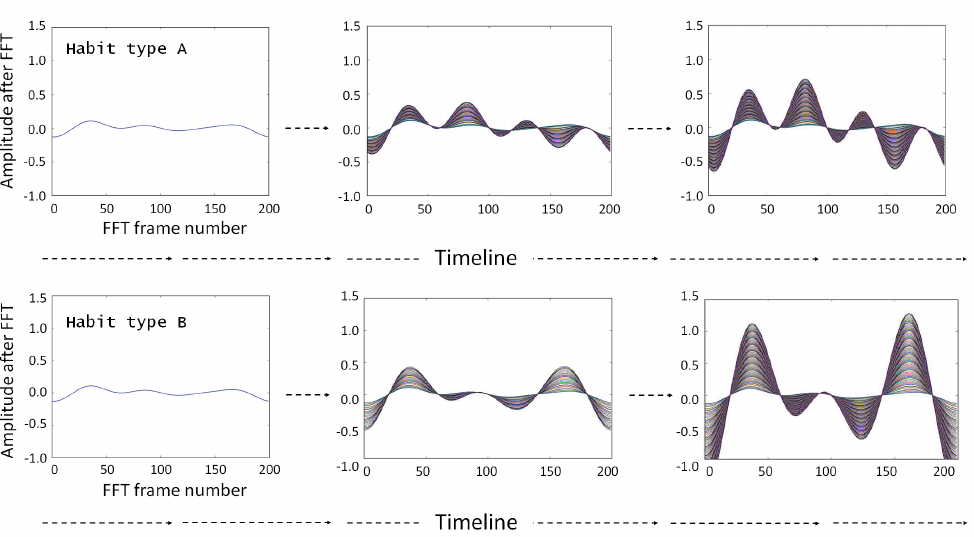
Figure 5. Changes of forms in the two different types of habits over a period of